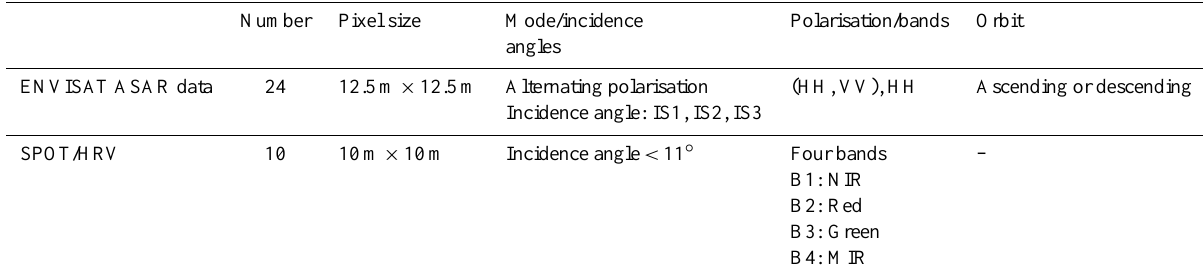
Table 1. Characteristics of ENVISAT ASAR and SPOT data used in this study. Number Pixel size Mode/incidence Polarisation/bands Orbit angles ENVISAT ASAR data 24 12.5m × 12.5m Alternating polarisation (HH, VV), HH Ascending or descending Incidence angle: IS1, IS2, IS3 SPOT/HRV 10 10m × 10m Incidence angle < 11 ◦ Four bands – B1: NIR B2: Red B3: Green B4: